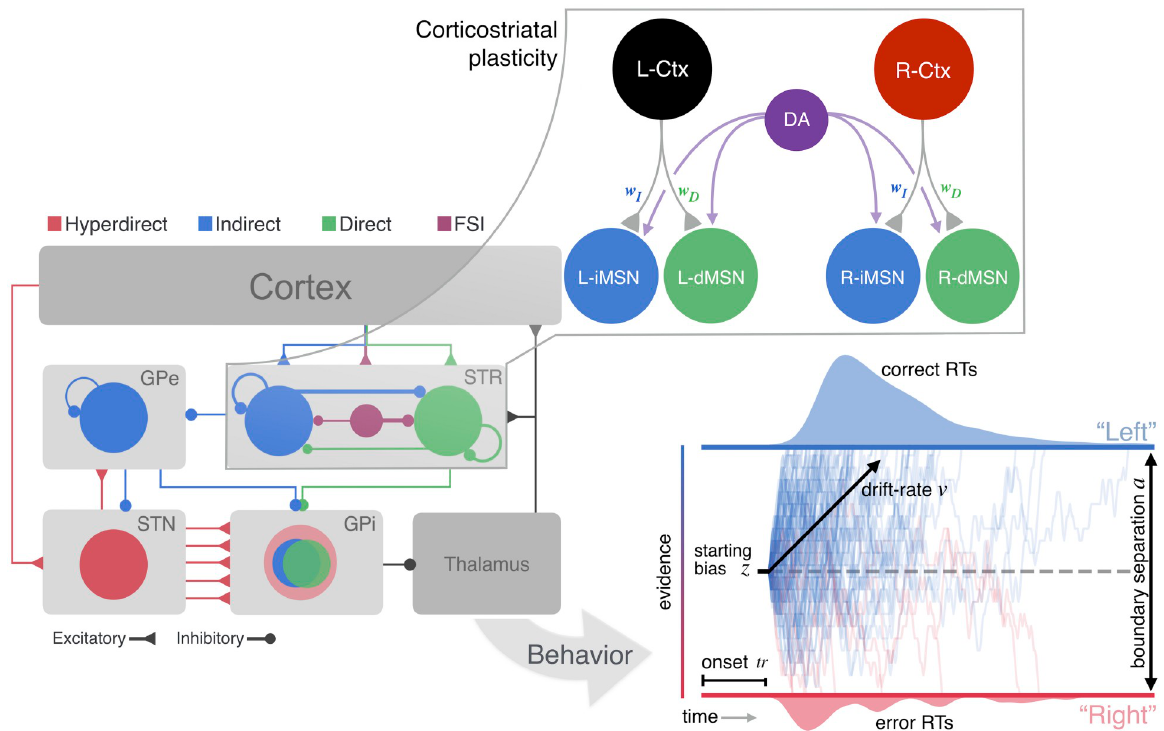
Fig 1. Multi-level modeling design. A STDP model of DA effects on Ctx-dMSN and Ctx-iMSN synapses is used to determine how phasic DA signals affect the balance of these synapses. A spiking model of the CBGT pathways simulates behavioral responses, under different conditions of Ctx-MSN efficacy based on the STDP simulations. The simulated behavioral responses from the full CBGT network model are then fit to a DDM of two-alternative choice behavior. Notation: j − Ctx —cortical population, j − dMSN —direct pathway striatal neurons, j − iMSN —indirect pathway striatal neurons ( j 2 { L , R }); DA—dopamine signal; STR—striatum; GPe—globus pallidus external segment; STN—subthalamic nucleus; GPi—globus pallidus internal segment; FSI—fast spiking interneuron; RT—reaction time; v —DDM drift rate; a —separation between boundaries in DDM; z —bias in starting height of DDM; tr —time after which evidence accumulation begins in DDM.